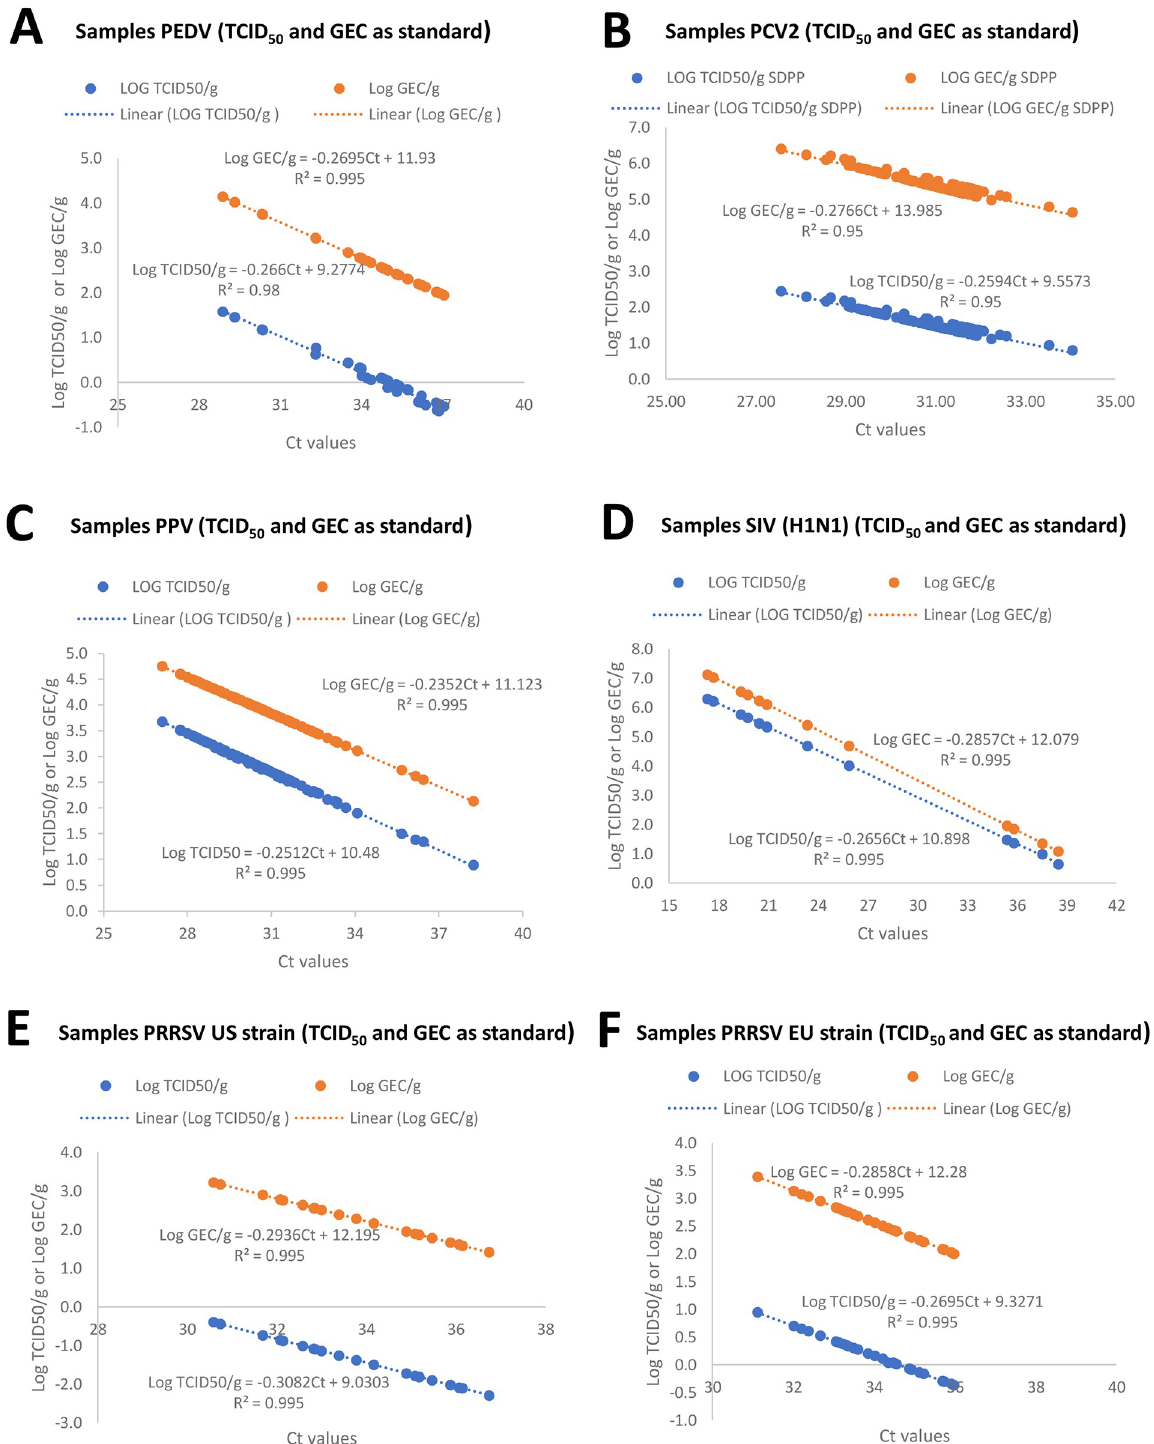
Fig 1. Regression curves between Ct values and tissue culture infectious dose 50 (TCID 50 /g) or Genome equivalent copies (GEC/g) of spray- dried porcine plasma (SDPP). Values expressed in log 10 TCID 50 /g SDPP or log 10 GEC/g SDPP. Each box includes the spot values of the SDPP samples analyzed and the regression equation between Ct and TCID 50 /g or GEC/g SDPP and the r 2 value. A.Regression curves for porcine epidemic diarrhea virus (PEDV); B. Regression curves for porcine circovirus type-2 (PCV-2); C. Regression curves for porcine parvovirus (PPV); D. Regression curves for swine influenza virus (SVI) H1N1; E. Regression curves for porcine reproductive and respiratory syndrome virus (PRRSV) US strain; F. Regression curves for PRRSV EU